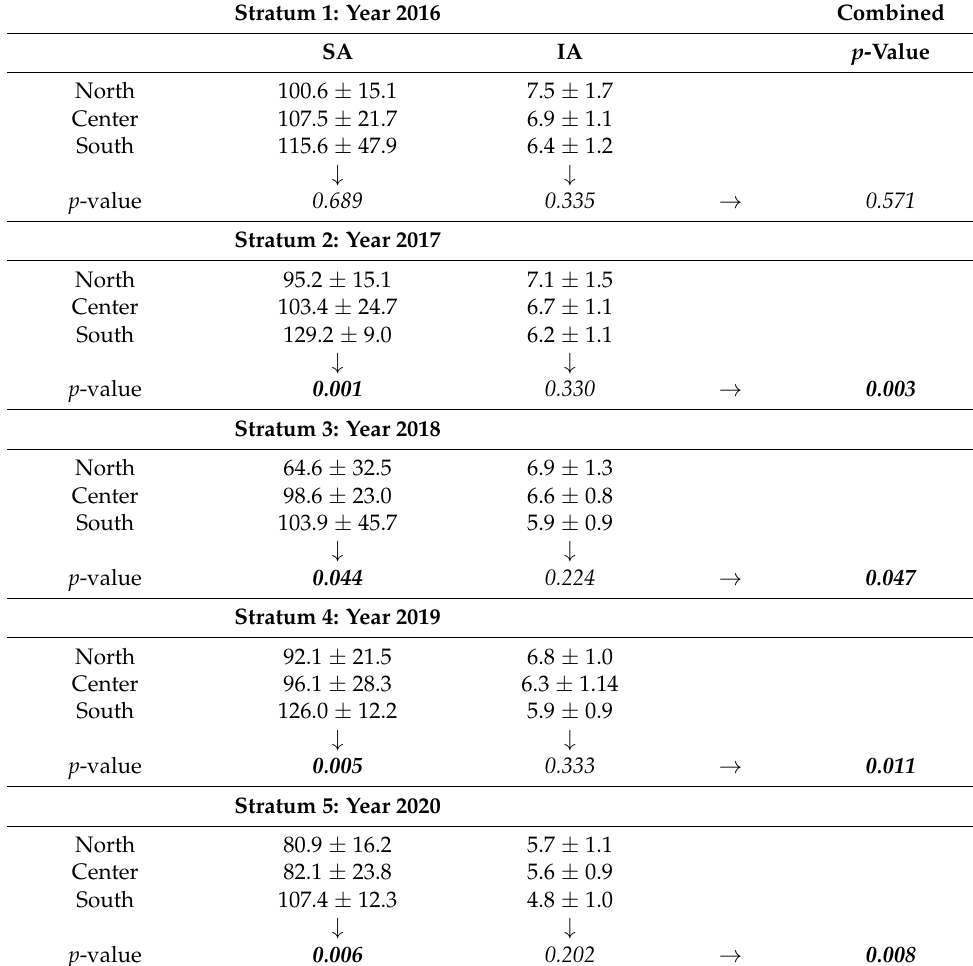
Table 1. Mean ± SD and combined p -value of SA and IA standardized rates stratifying for